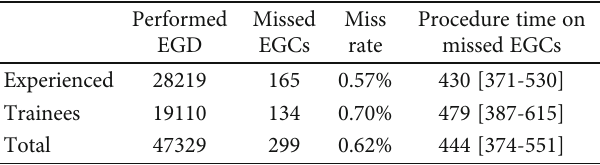
Table 3: Miss rate and procedure time on missed EGCs between experienced and trainee